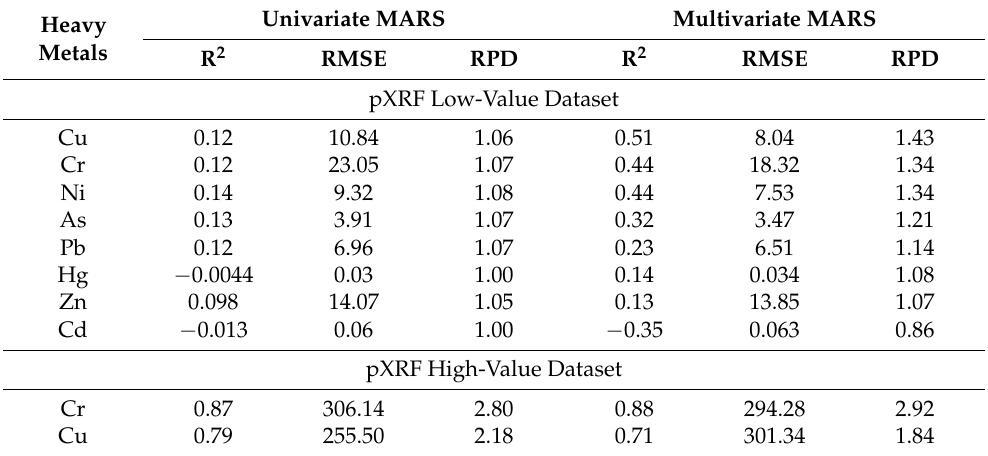
Table 4. Validation statistics for predictive results of heavy metals of sample in the pXRF low-value dataset and Cr and Cu of sample in pXRF high-value dataset using univariate and multivariate MARS